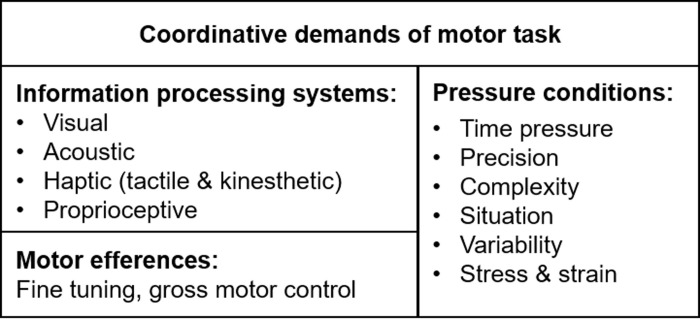
Coordination model of [17].